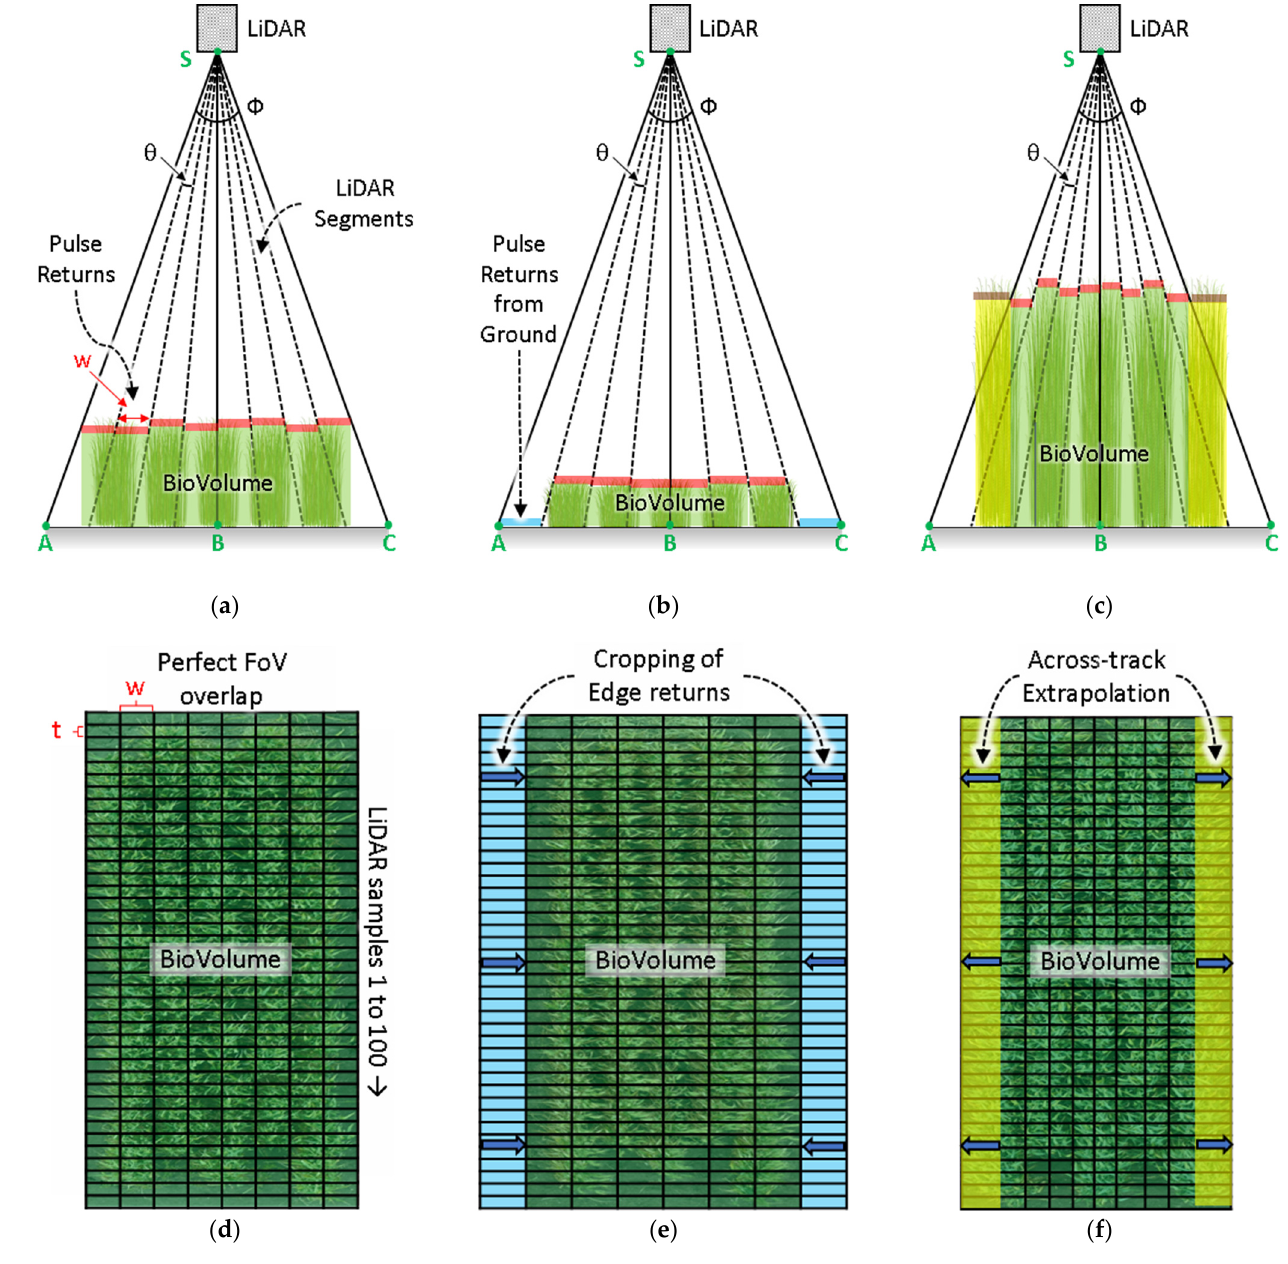
Figure 7. Signal processing to extract BioVolume. The frontal views of the CropBioMass (CBM) sensor geometry for ( a ) medium-, ( b ) short-, and ( c ) tall-sized plots. The top views showing the detector footprint for ( d ), medium-, ( e ) short-, and ( f ) tall-sized plots. The footprint of the individual LiDAR segments vary with the crop height. Short-sized plots are farther from the CBM providing extended FoV coverage area, therefore, the segments on the edge are required to be removed. Tall-sized plots are closer to the CBM providing smaller FoV coverage areas; therefore, extrapolation is required to account for the missed plants on the edge.